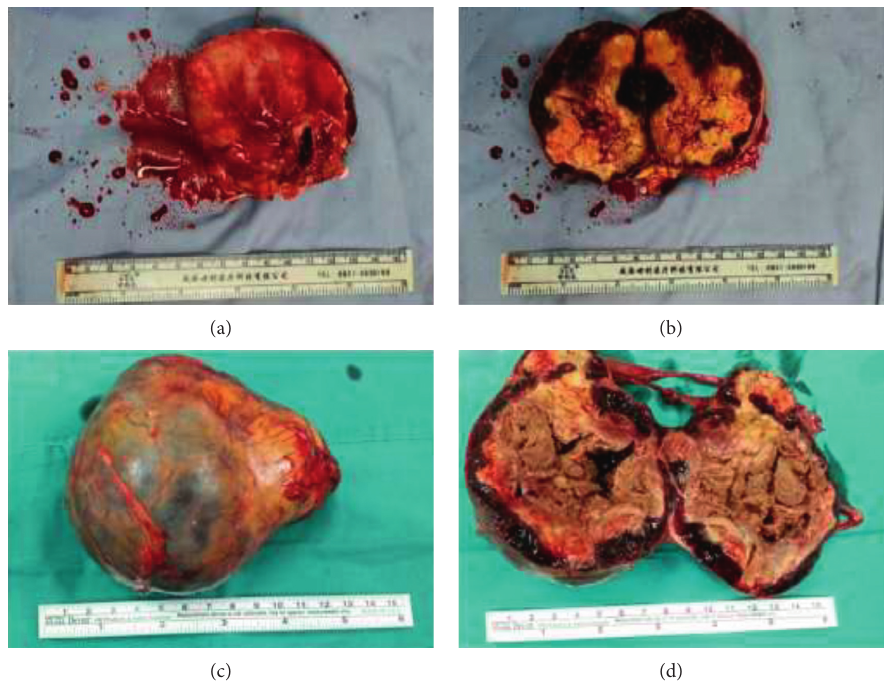
Figure 4: The specimen of ACH. (a-b) Gross appearance revealing a completely encapsulated and moderately firm round mass measuring 8 × 6 × 6cm, with a cross section of reddish-brown and ash-gray organized hematoma. (c-d) Pathological examination revealed a resected oval mass measuring 11 × 8 × 6cm, which was spongy and yellowish with a central area, whitish peripheral capsule, and hard